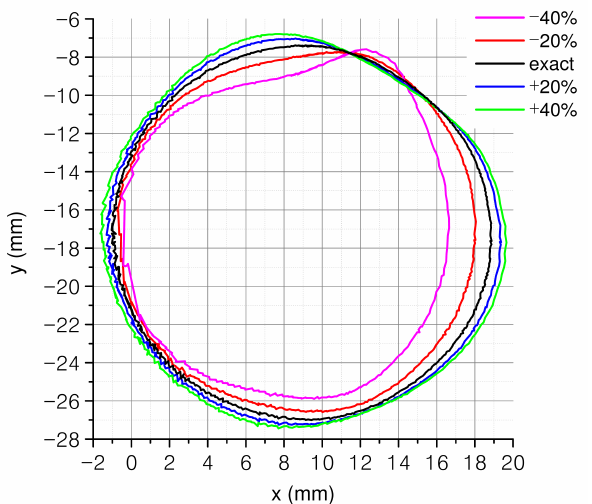
Figure 5. Tracking of xy projections as obtained with 8P, using for | (cid:126) m | its value resulting from 9P (black) and values increased (blue, green) or decreased (red, magenta) by 20% and 40%,